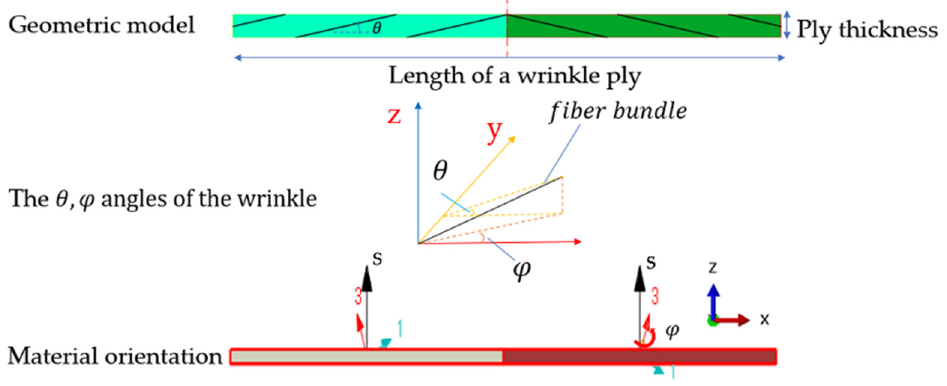
Figure 4. The wrinkle in RVE